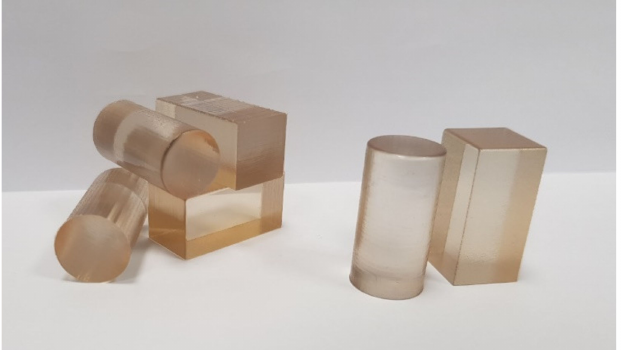
Figure 3. Standard samples with cylindrical and rectangular